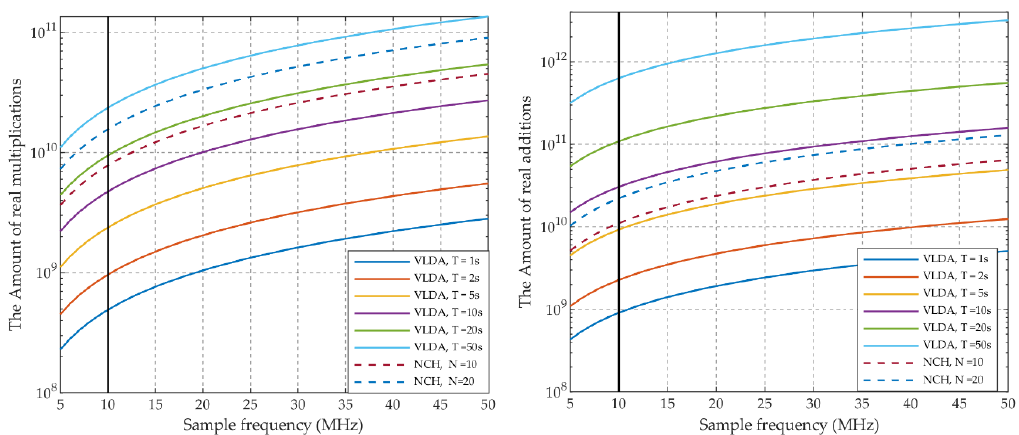
Figure 7. Comparison of the calculation amount between VLDA and non-coherent (NCH) methods. Figure 7 Comparison of the calculation amount between VLDA and non ‐ coherent (NCH) methods. ( a ) Amount of real multiplications; ( b ) Amount of the real ( a ) Amount of real multiplications; ( b ) Amount of the real additions.